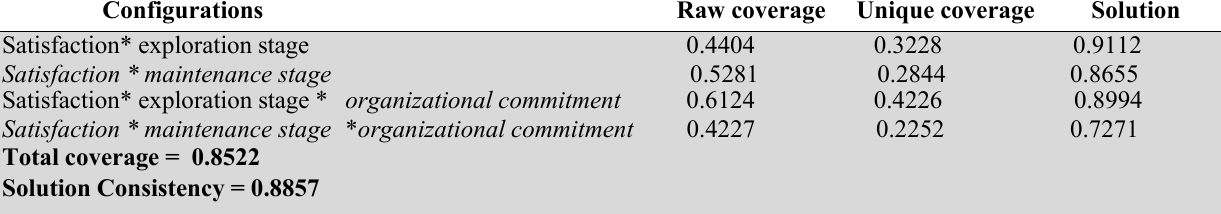
Configurations leading to the presence of a high level of task performance